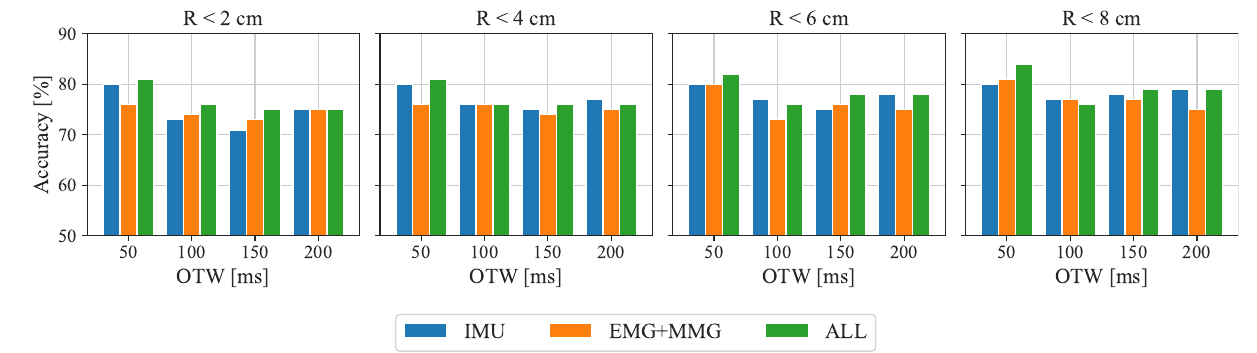
Figure 7. Prediction accuracy of the “reaching” task for different combinations of input features considering all subjects. The performance of the analysis mainly targets the LSTM model. The blue bars represent the results that only use kinematic input features labeled as IMU. The orange bars refer to the physiological features input only, labeled as EMG + MMG. Results with the combinations of input features are shown in green (labeled as all).